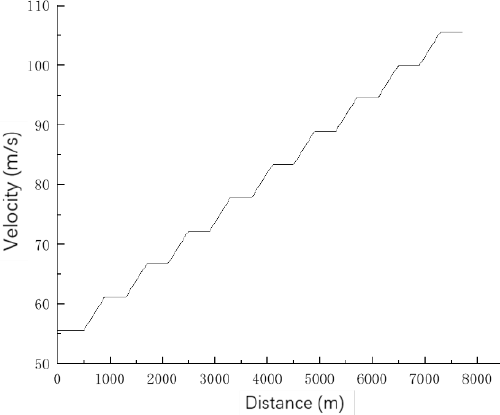
Figure 3. The running speed of the vehicle on the curve.